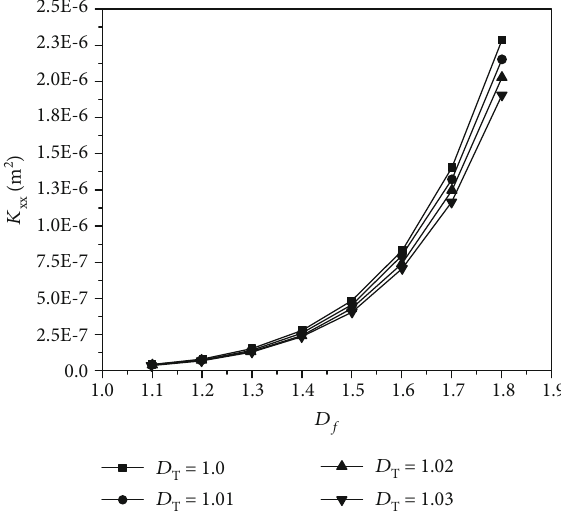
Figure 4: The relationship between K and α = π /2 ). w